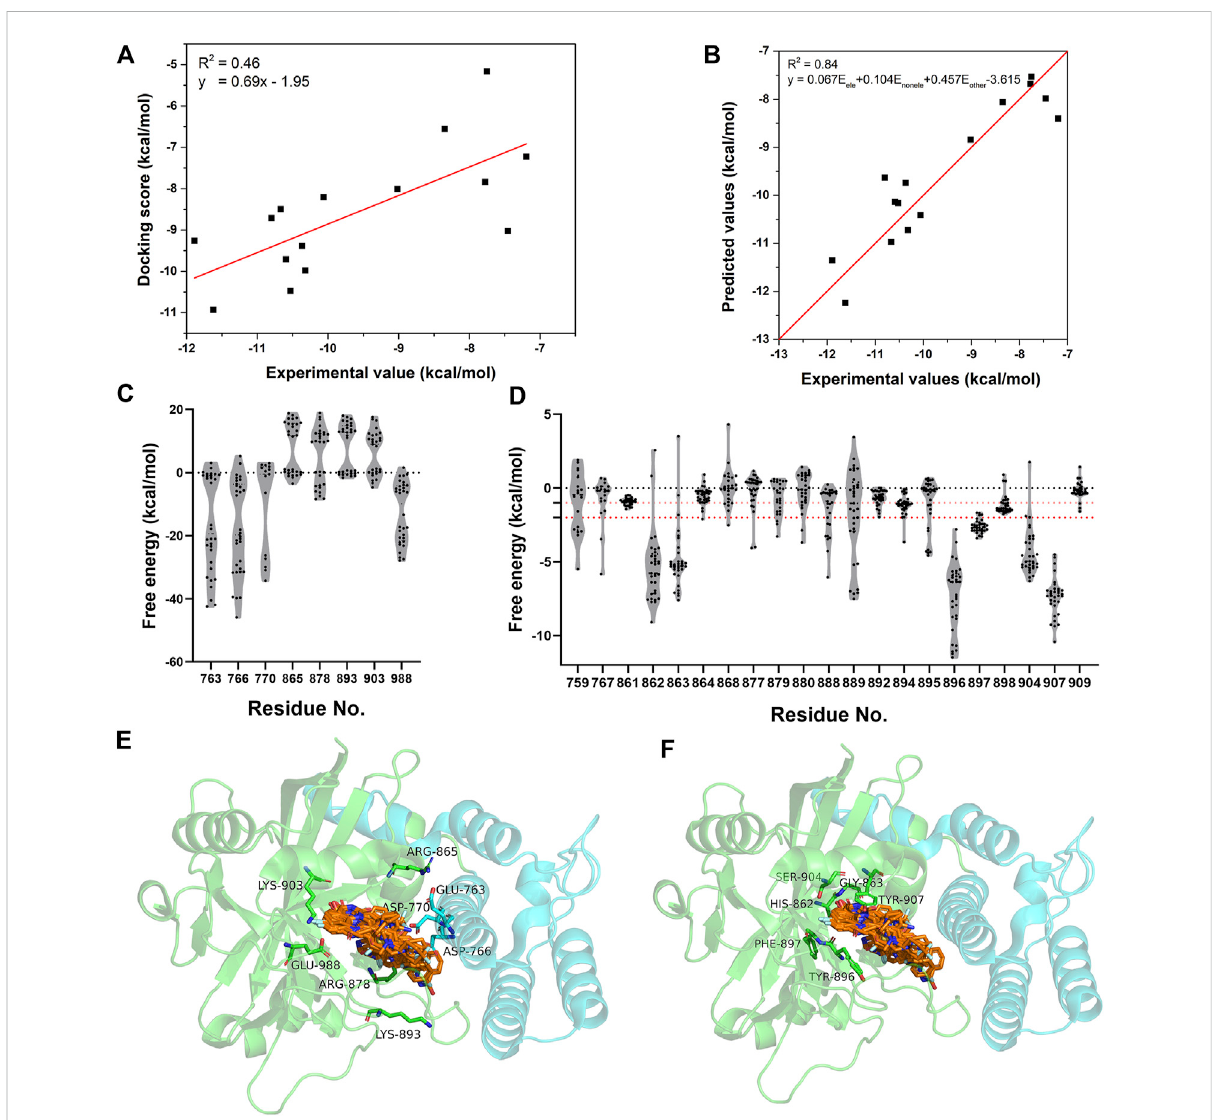
FIGURE 2 The energetic characteristics of PARP-1 complex by per-residue energy decomposition in molecular docking. (A) The linear relationship between the docking scores and experimental activities for 15 PARP-1 ligands. (B) The linear relationship between the predicted activities and experimentalactivitiesbyamultiplelinear regression model. (C,E) Theper-residueenergydistributionandlocationofelectrostaticresiduegroupon PARP-1. (D,F) The per-residue energy distribution and location of non-electrostatic residue group on